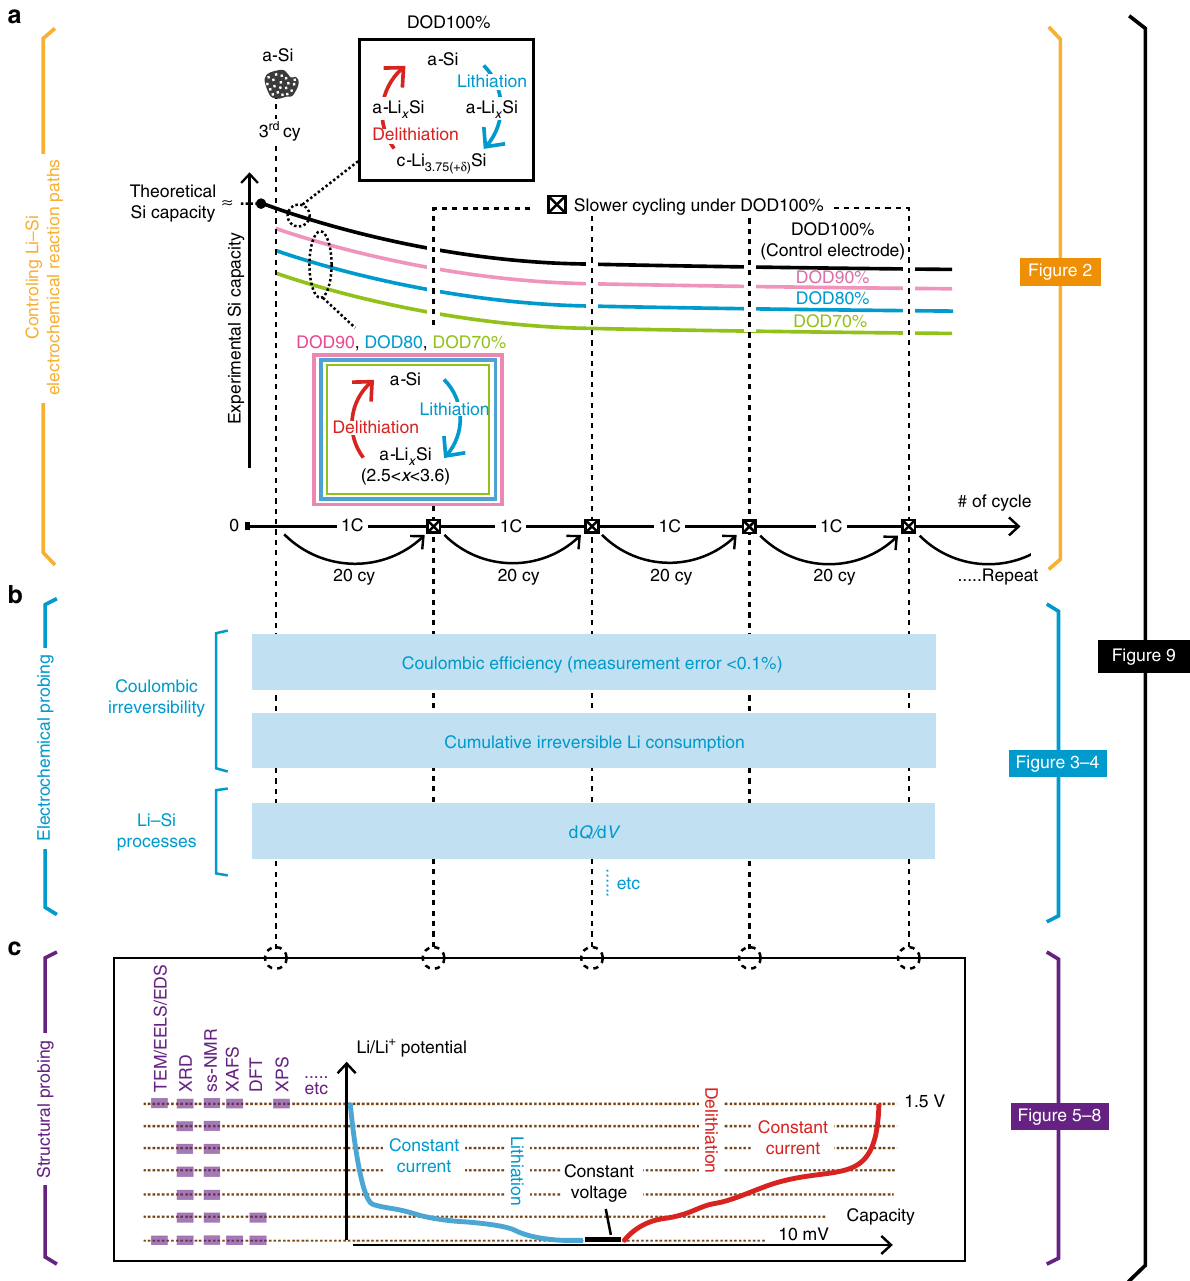
Fig. 1 Schematics of experimental scheme. The overall experimental scheme is illustrated in ( a – c ). a Li – Si electrochemical reaction paths are controlled by capacity-cutoff depth of discharge (DOD)%. After polycrystalline Si nanoparticles (pc-SiNP) are fully amorphized in the fi rst two cycles, DOD% is controlled from the third cycle on to 70, 80, 90, or 100% (indicated by green, blue, pink, and black solid lines, respectively). As shown in colored rectangular boxes, under the DOD100% protocol, the system displays an amorphous – crystalline Li – Si phase transformation, while DOD70 – 90% displays amorphous – amorphous volume changes. b Electrochemical outputs to be probed under different DOD controls, such as Coulombic ef fi ciency (CE), and cumulative irreversible Li consumption, and d Q /d V pro fi les. The capacity of electrodes is carefully designed such that the fi rst reversible capacity under DOD100% agrees with the Si theoretical capacity to ~99% accuracy (see Methods under “ Baseline active materials ” ). c Various analyses used for structural probing, which is conducted every 20 cycles at slower current rates under DOD100%, in order to capture the structural characteristics for the full potential range for different DOD controls (see Methods under “ Electrode fabrication and cycling conditions ” ). Figures corresponding to ( a – c ) in the following section are labeled on the right nanoparticles (pc-SiNP) and multiwall carbon nanotubes current constant voltage (CCCV) mode on lithiation, and con- (MWCNT) with or without fl ake-type graphite (Gr; for details see stant current (CC) mode on delithiation (Methods under “ Elec- Supplementary Table 4 and Methods under “ Baseline active trode fabrication and cycling conditions ” ). The active materials materials ” ). The electrodes are assembled in 2032-type Li-metal- are designed to form a porous structure for better wettability countered coin half-cells, and they are cycled under constant (Figs. 2c, d) and ensure the accessibility of Li ions to Si surface.